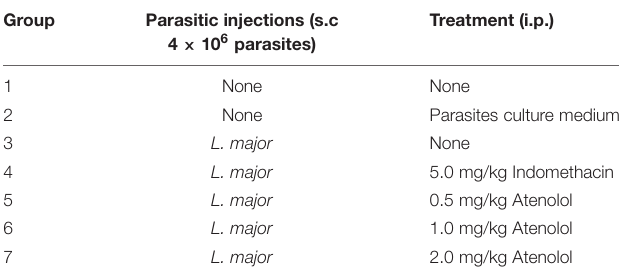
TABLE 1 | Experimental groups used in the behavioral tests.